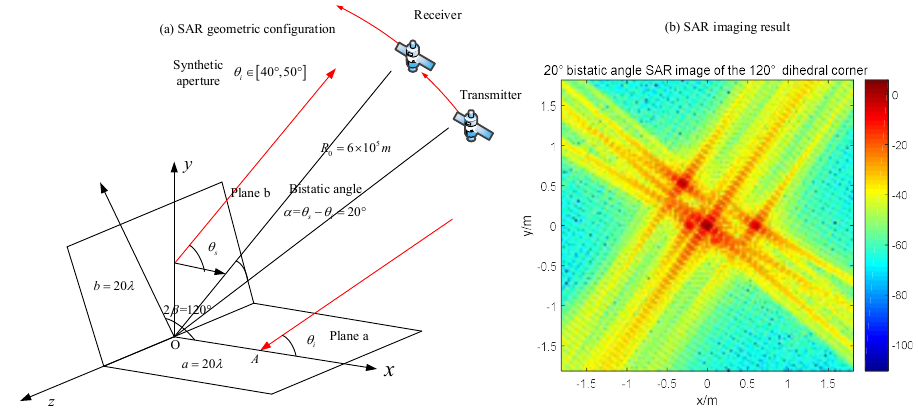
Figure 22. 20° bistatic angle SAR image of the 120° obtuse dihedral corner ( a ) geometric configuration; ( b ) imaging result.